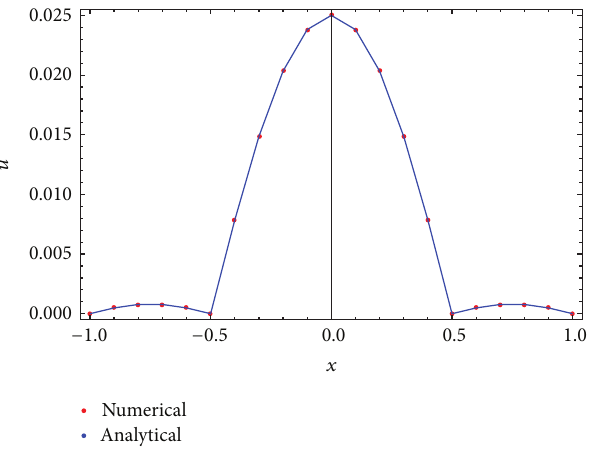
Figure 5: Numerical and analytical solution plot (12 nodes), with constant basis-Problem